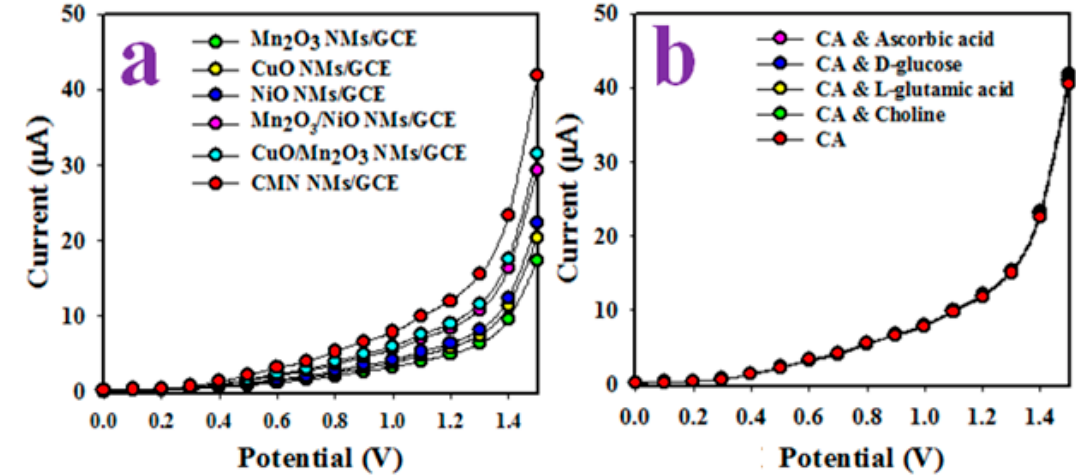
Figure 6. Optimization of the sensor probe. ( a ) Control experiments to evaluate the electrochemical activities of various NMs, and ( b ) interferences effect of sensor probe in the detection of CA with the presence of biochemical.